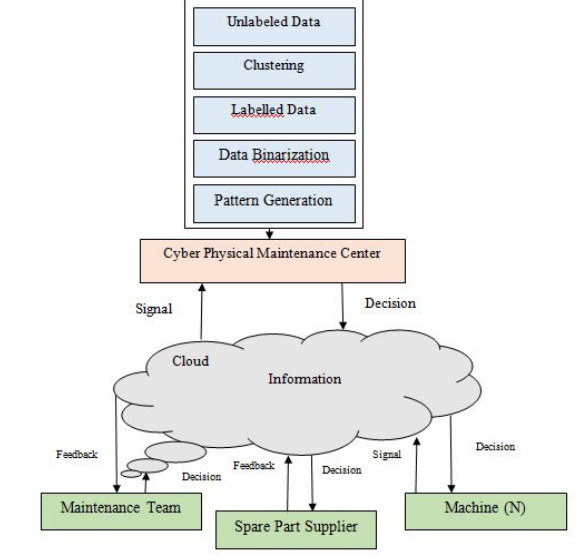
Figure 4: Cyber-physical system